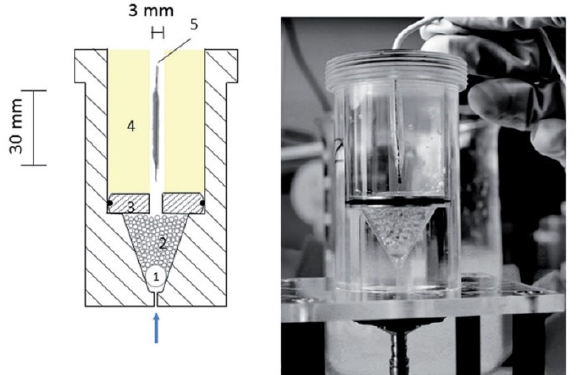
Figure 8. Schematic drawing of the flow through cell: 1 large glass bead; 2 small glass beads; 3 metal disc; 4 hydrogel matrix; 5 drug eluting balloon (DEB), reprinted from [61].